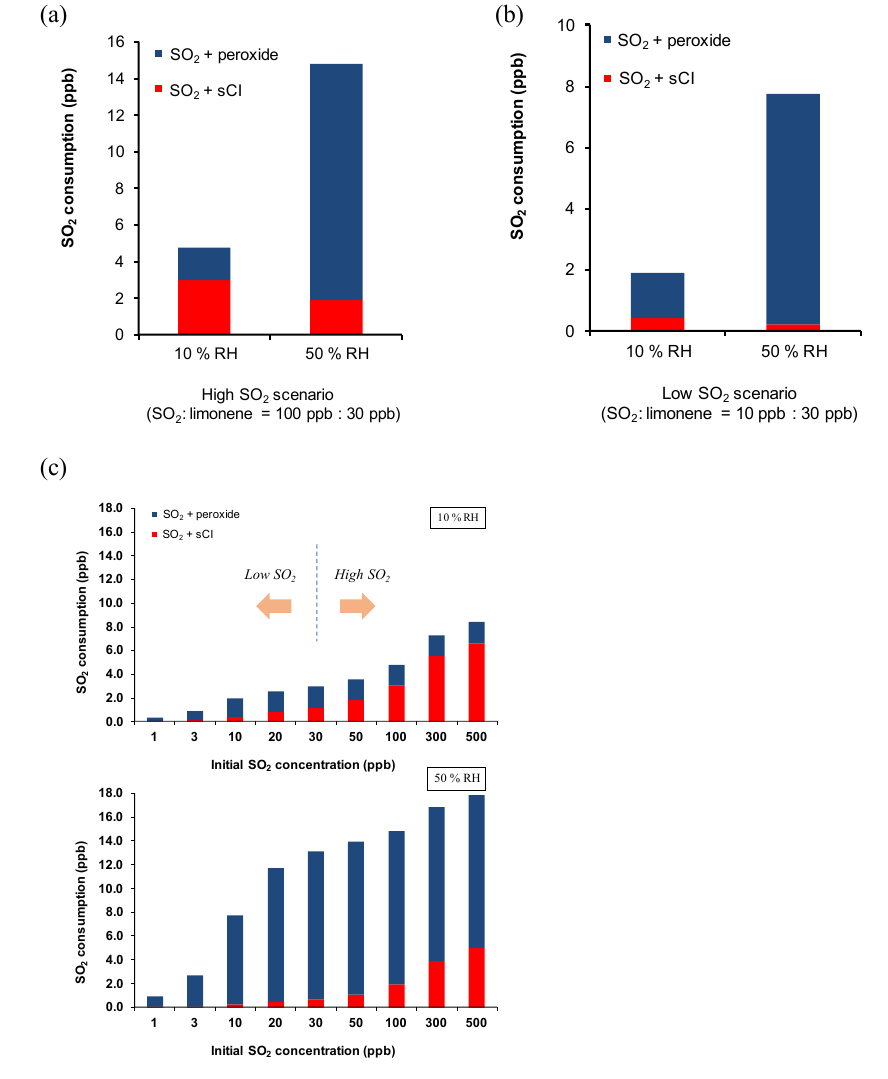
Figure 8. SO 2 consumption through reactions with sCI and peroxide under different humidity conditions in a high SO 2 scenario (100ppb, a ) and a low SO 2 scenario (10ppb, b ). SO 2 consumption as a function of initial SO 2 concentration under different humidity conditions (c) .